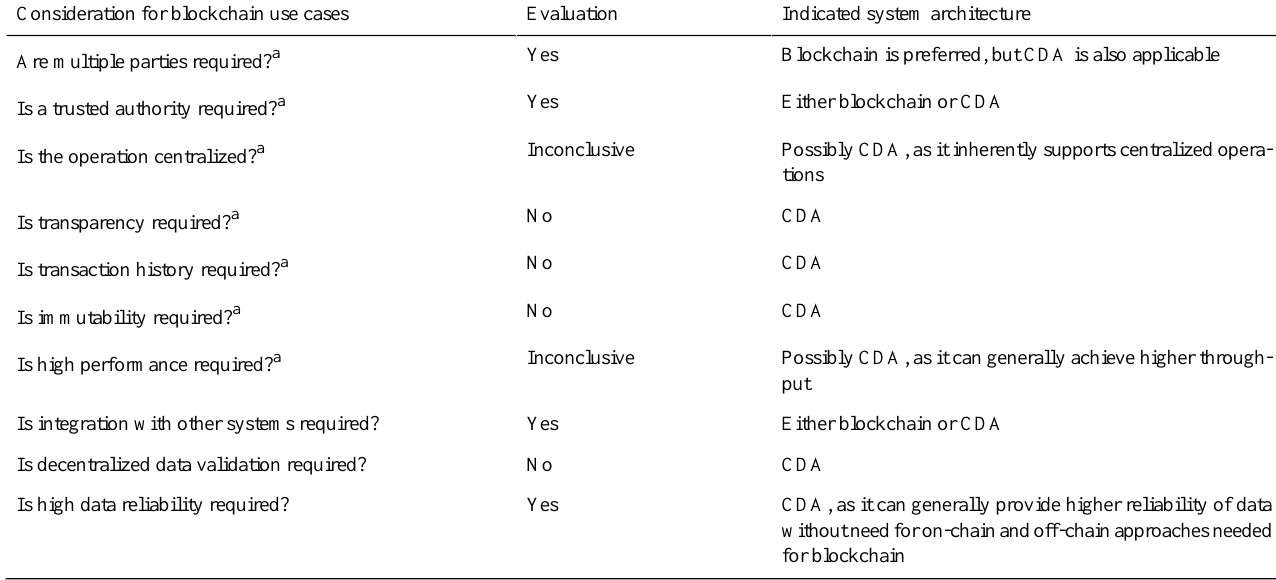
Table 1. Suitability evaluation of the applicability of blockchain technology to algorithmic contact tracing, with comparison to conventional database applications